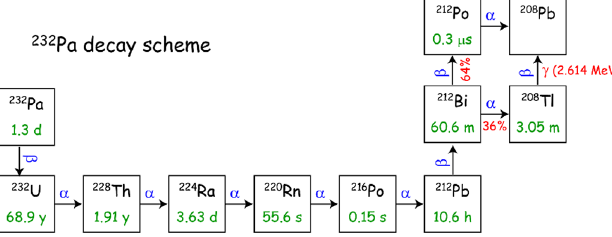
Fig. 4. 232 Pa decay chain leading to 208 Pb and the emission of the associated 2.6 MeV gamma ray. If the most attractive targets (Pa and U) are separated from the elements to their right, the gamma ray emission will be suspended for a relatively long time, allowing their